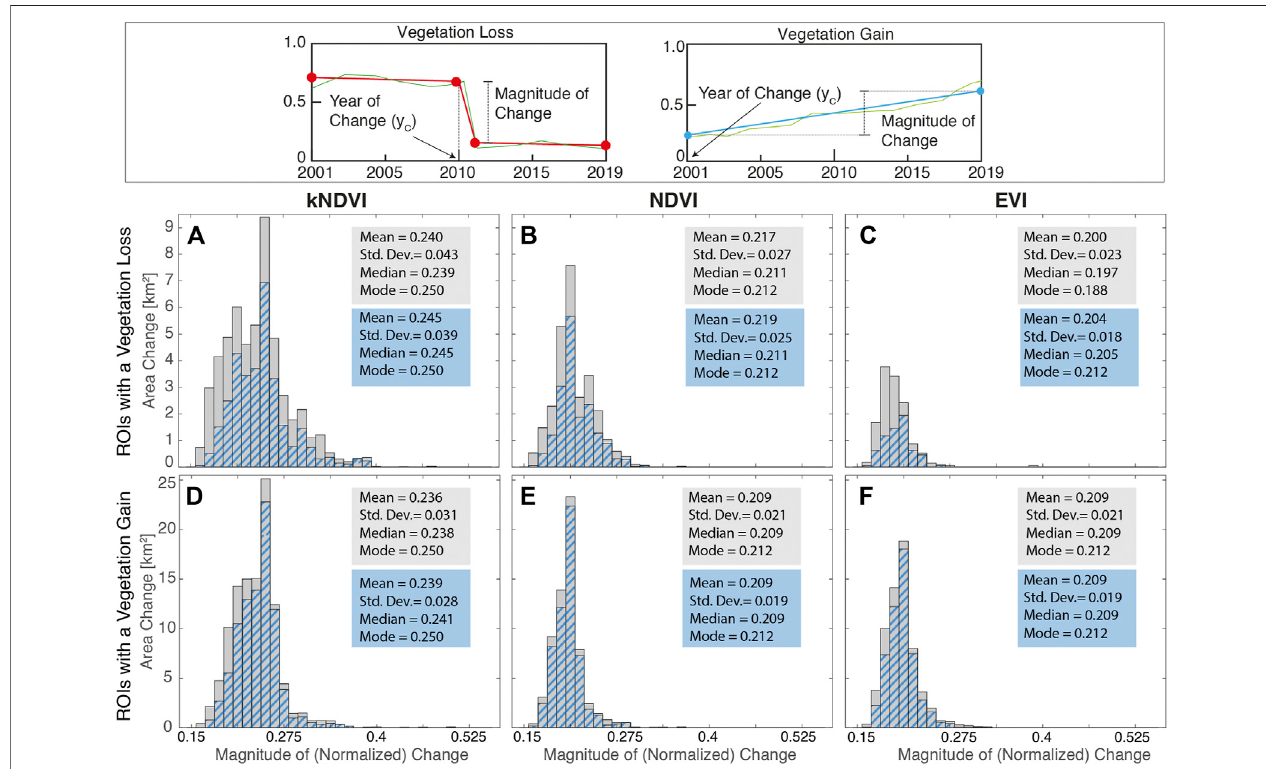
FIGURE 5 | Distribution of the (ROI-averaged) magnitude of (normalized) change. The top panel explains how this quantity has been evaluated for a single pixel. Distributionsin (A) – (F) refertospatialmeanvaluesofthemagnitudewithineachROI.Theblue-dashedportionofthedistributionsreferstothesubsetofROIswhereinan hydrologicalalterationalsooccurred. (A) – (C) refertotheROIswithalosswhereas (D) – (F)